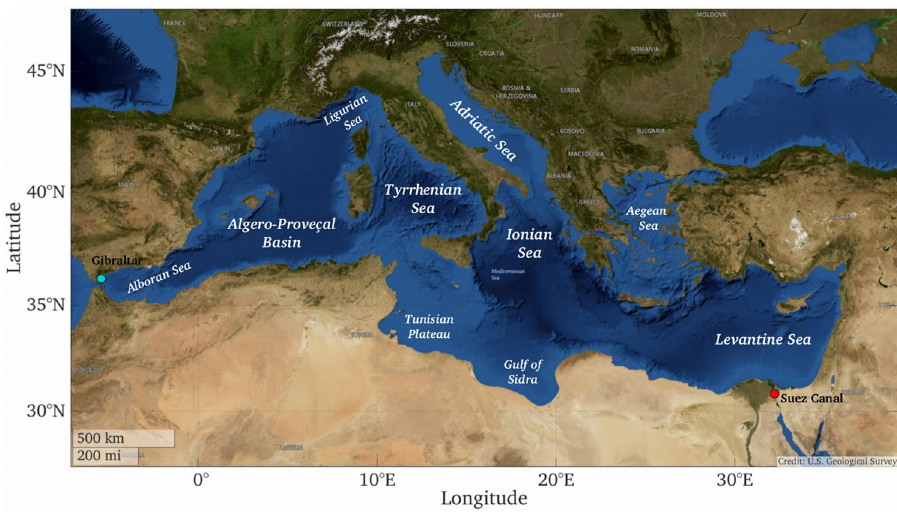
Figure 1. The Mediterranean Sea and its sub-basins. The red dot indicates the Suez Canal, which physically connects the Red Sea with the Levantine Sea; the green dot shows the Gibraltar Strait location, from which Atlantic waters enter the Mediterranean Sea near the surface, and vice versa at depth. (USGS Imagery Topo: courtesy of the U.S. Geological Survey. Map visualization produced with Matlab R2018a, https:// www. mathw orks.